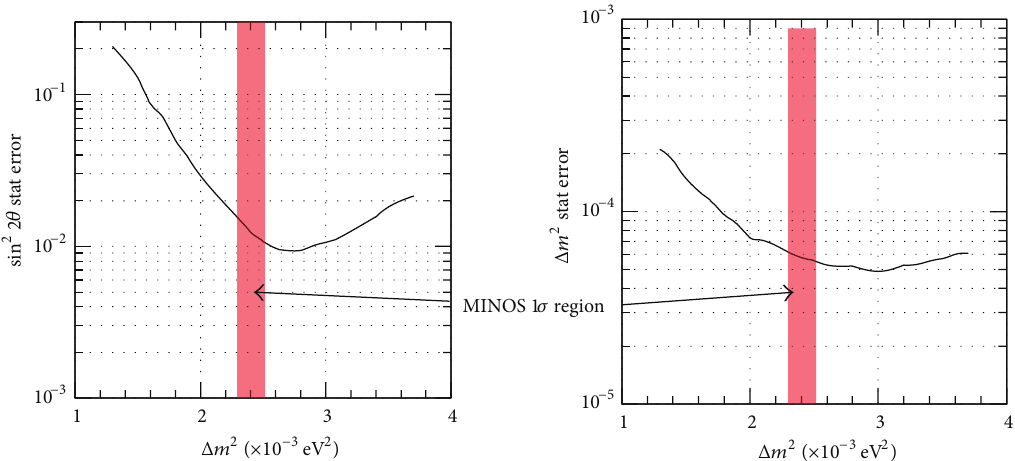
Figure 23: T2K expected statistical precision on the oscillation parameters sin 2 (2𝜃 23 ) and |Δ𝑚 2 32 | assuming an exposure of 750 kW × 5 × 10 7